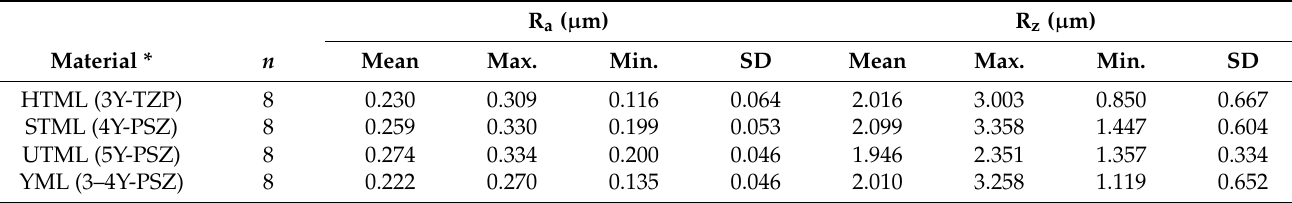
Figure 9. Zirconia surface with fine grooves parallel to the polishing direction. Table 2. Roughness values R a and R z after